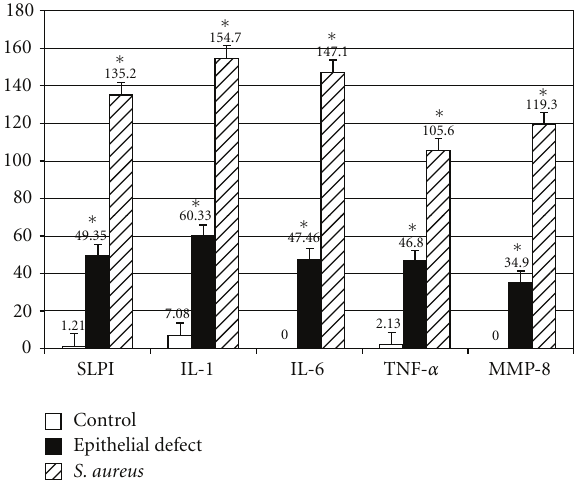
Figure 4: Comparison of S . aureus , epithelial defect, and control corneas in terms of quantified expression of SLPI, proinflammatory cytokines, and MMP-8 from Western blots. The results shown are the mean ± SD. Di ff erences between values are statistically significant ( ∗ P < . 05 compared with untreated